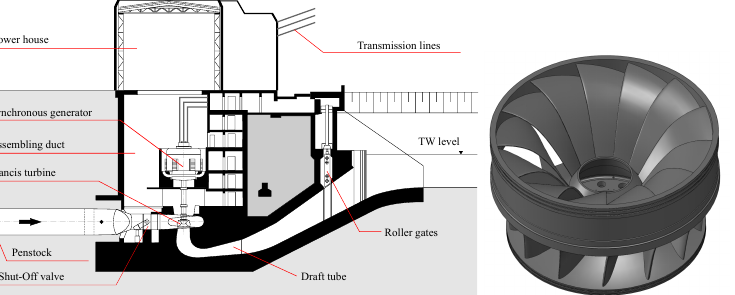
Figure 17. Method application to Hydropower plant ( left : Power plant cross-section; right : investi- gated Francis runner with n q = 62.2 min − 1